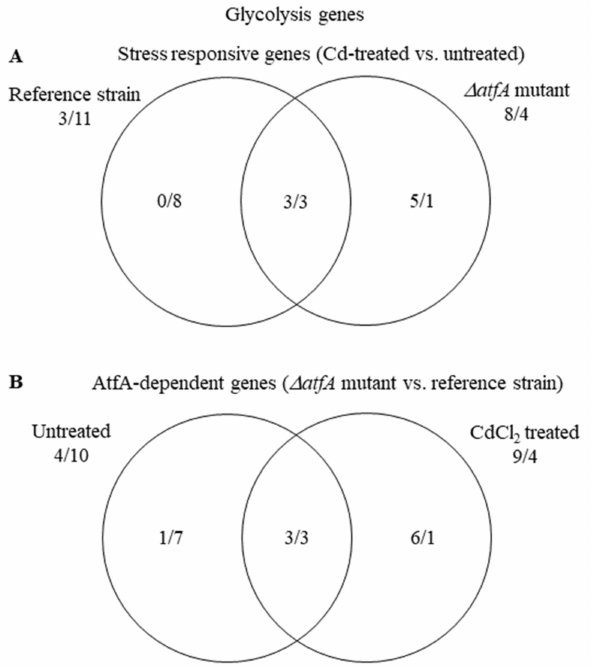
Figure 8. Distribution of stress responsive “Glycolysis” genes between the THS30 reference strain and the TNJ92 ∆ atfA mutant ( A ) as well as of the AtfA-dependent “Glycolysis” genes between the untreated and CdCl 2 -treated cultures ( B ). Figures represent the number of up-regulated/down- regulated genes. Further data on the gene group are available in Table